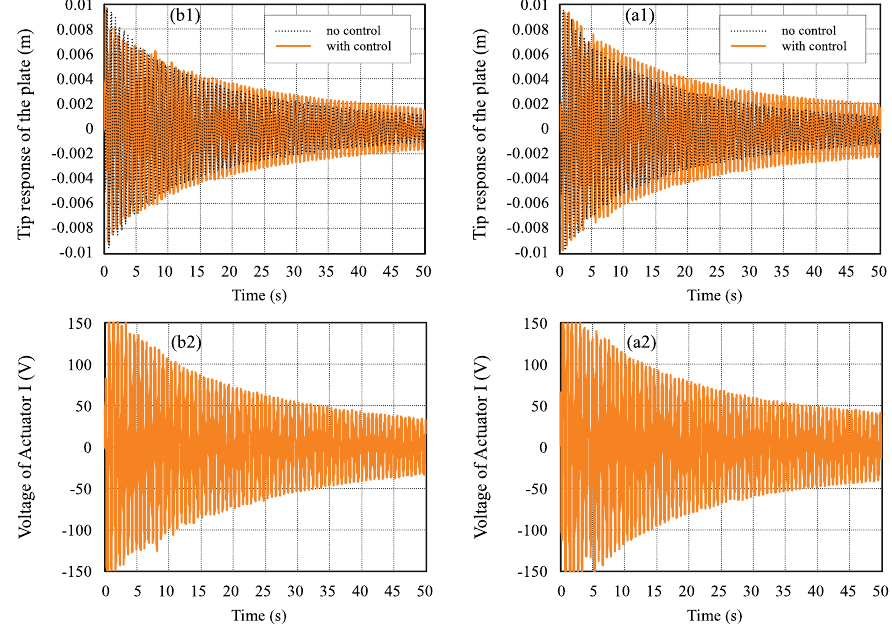
Fig. 10. Response of the plate and applied voltage of Actuator I when K = [1 . 4542 , 35 . 0246] and K (cid:4) = [ − 49 . 2654 , 62 . 1756] are used for the plate with time delay τ = 0 . 09s , respectively (one actuator case). (a) experimental result ( K (cid:4) = [ − 49 . 2654 , 62 . 1756] ); (b) experimental result ( K = [1 . 4542 , 35 . 0246]